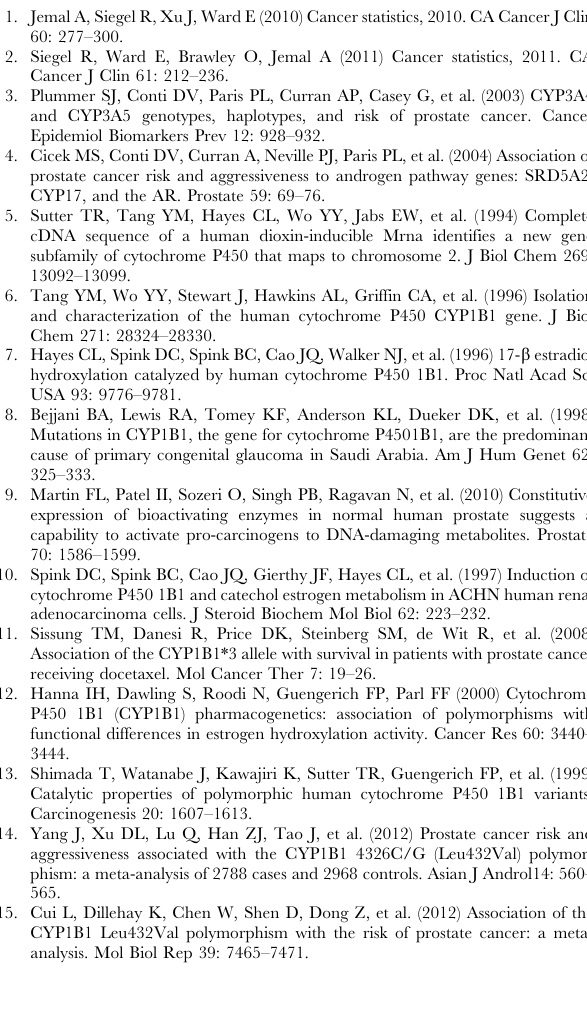
Table S1 Some corresponding pooled ORs were mate- rially altered in sensitivity